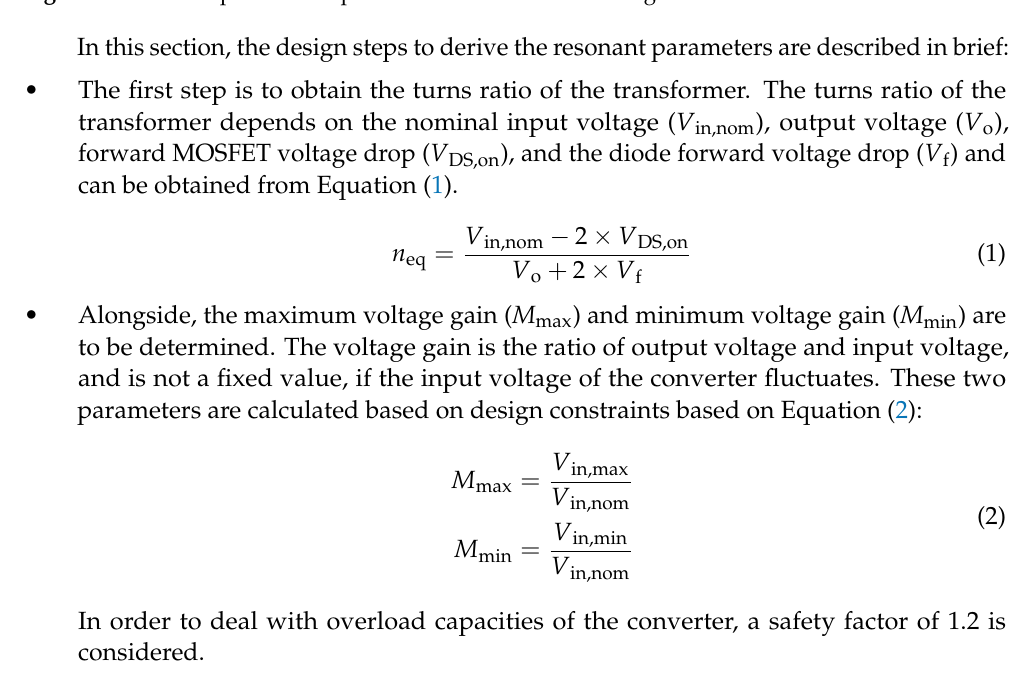
Figure 8. Iterative optimization process for LLC converter